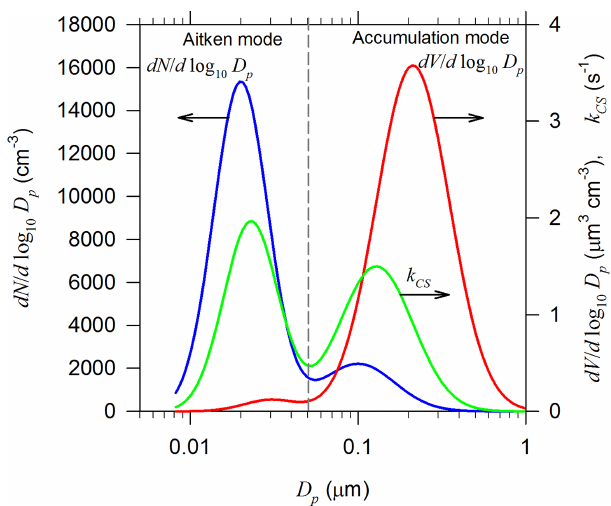
Figure 11. Initial aerosol number and volume size distributions along with the condensational sink k CS . The dashed line demar- cates the Aitken mode from the accumulation mode and the initial condensation sink is such that the sum of k CS over all the size bins in the Aitken mode is equal to that in the accumulation